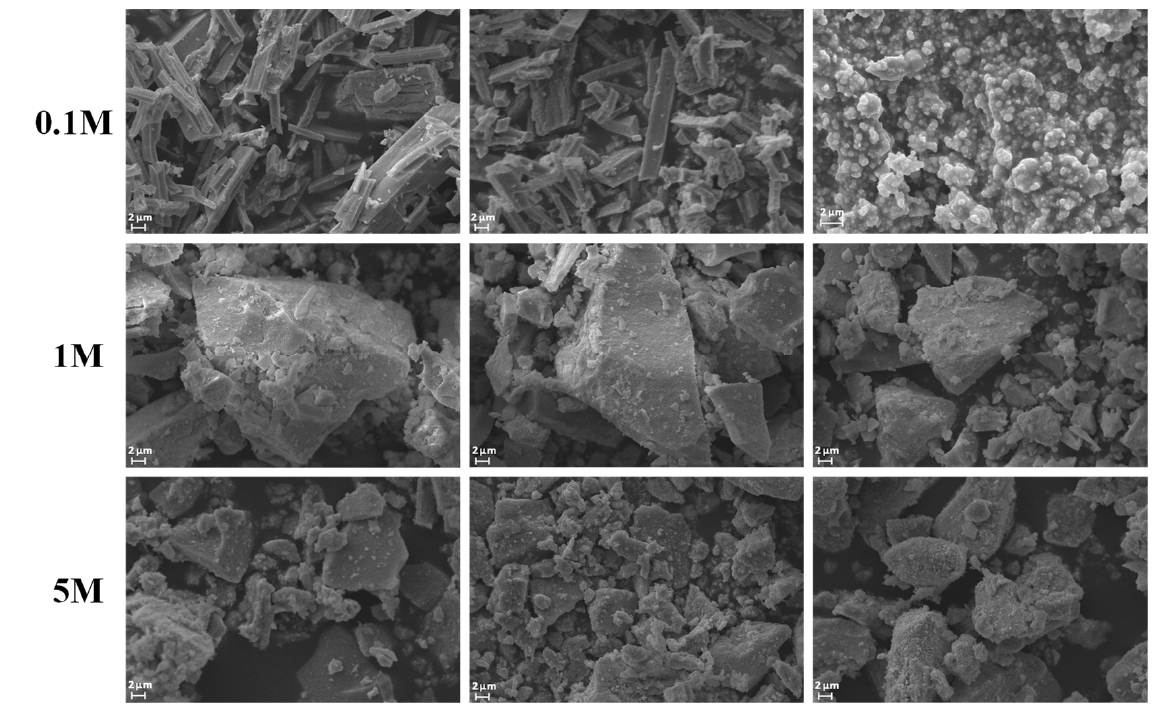
Figure 1. SEM images (scale bar at 2.0 μ m) from the different hydrothermally prepared pure ceria sub- strates.